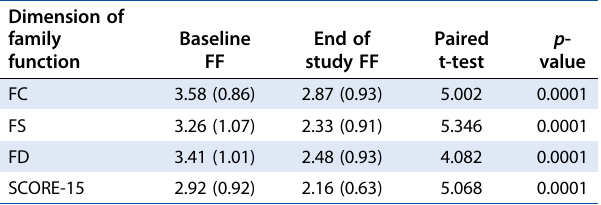
Table 4: Dimension of family function (SCORE-15) of study participants who received counselling Dimension of family